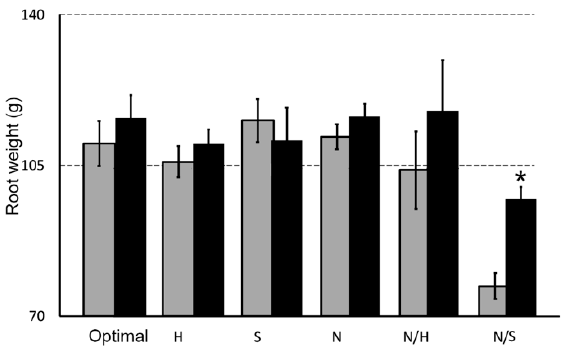
Figure 4. Effects of APR® on shoot weight in response to different single and combined abiotic stresses. Maize seedlings were subjected for 3 days to several abiotic stresses in absence (grey bars) or in presence (black bars) of 5% APR®. The applied single stresses were: hypoxic stress (H), salt stress (S), nutritional stress (N). The single stresses were combined as: hypoxic stress plus nutritional stress (N/H) and salt stress plus nutritional stress (N/S). The values of root weight (g) are represented in the graphs (mean ± SE) and were calculated from three independent experiments ( n = 10). Significantly different values are evidenced by * (*: p < 0.05; **: p < 0.02; One-way ANOVA, Tukey’s HSD test).